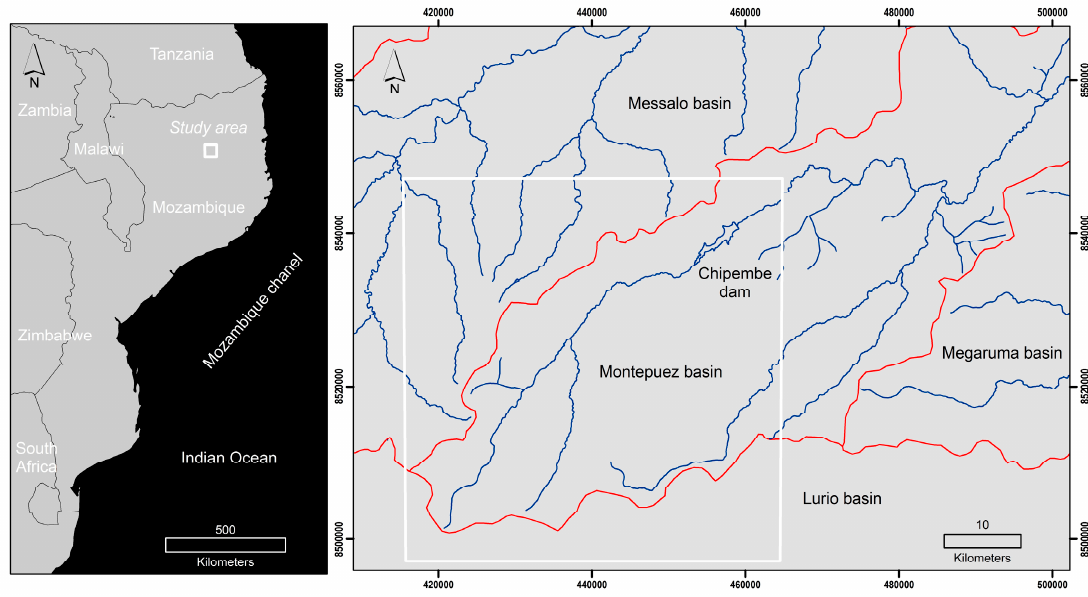
Figure 1. Study region and location of Chipembe dam.